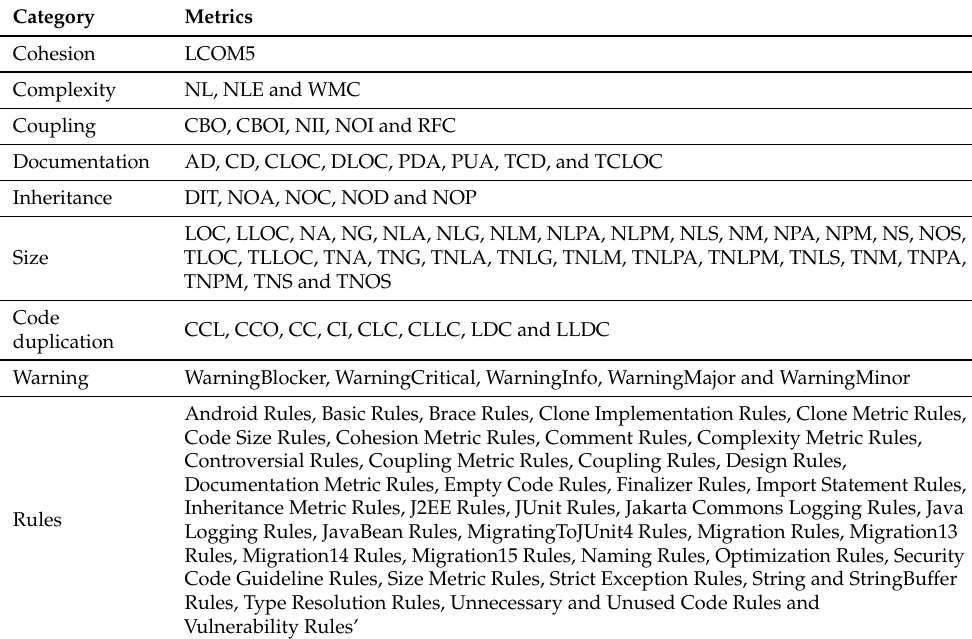
Table 6. Metrics used as independent variables and their